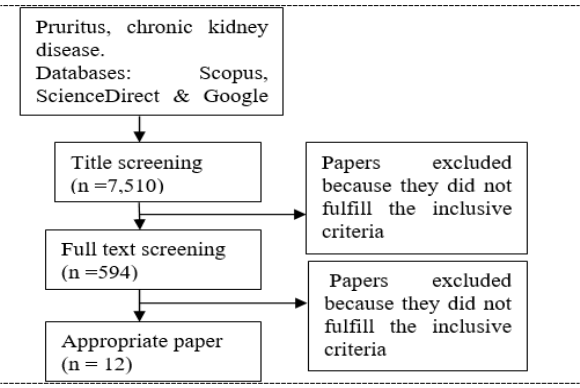
Figure 1. Flowchart of the research on pruritus and chronic kidney